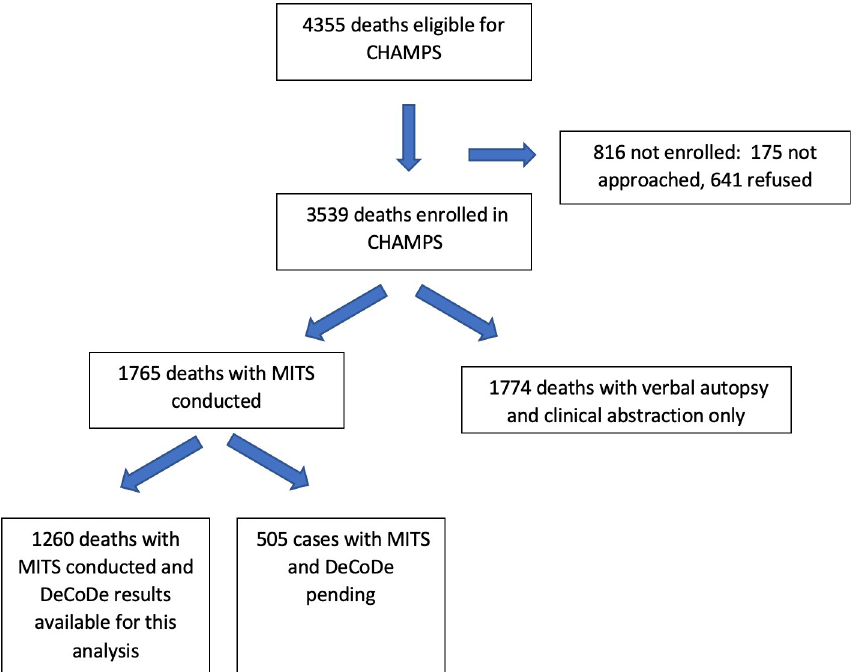
Fig 1. Flowchart of enrollment of deaths among children 0 to less than 5 years of age in CHAMPS sites, deaths with MITS procedure, and cases with CoDs determined by review panels (DeCoDe). Among 4,355 deaths eligible